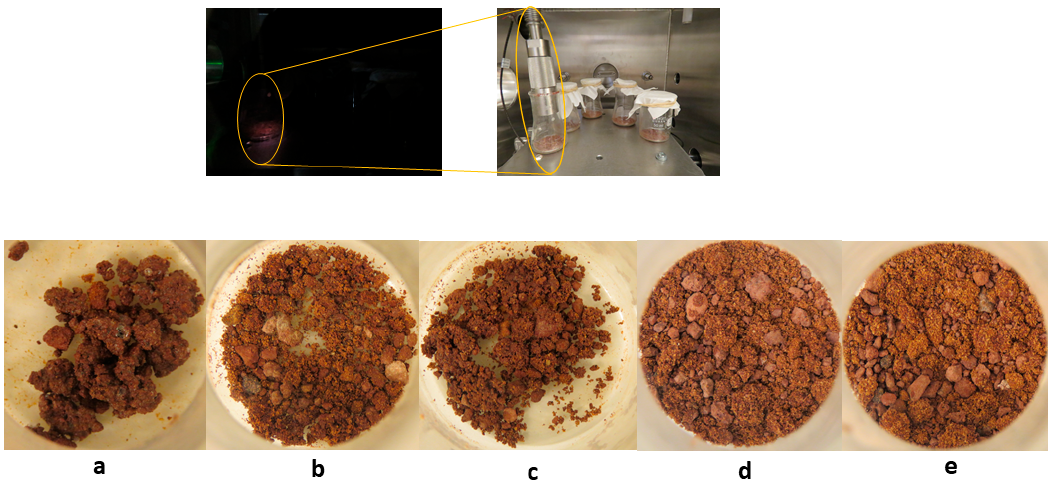
Figure 5. ( a ) 1 g soil, ( b ) 1.5 g soil with UV, ( c ) 1.5 g soil without UV, ( d ) 2 g soil, and ( e ) 2.5 g soil.